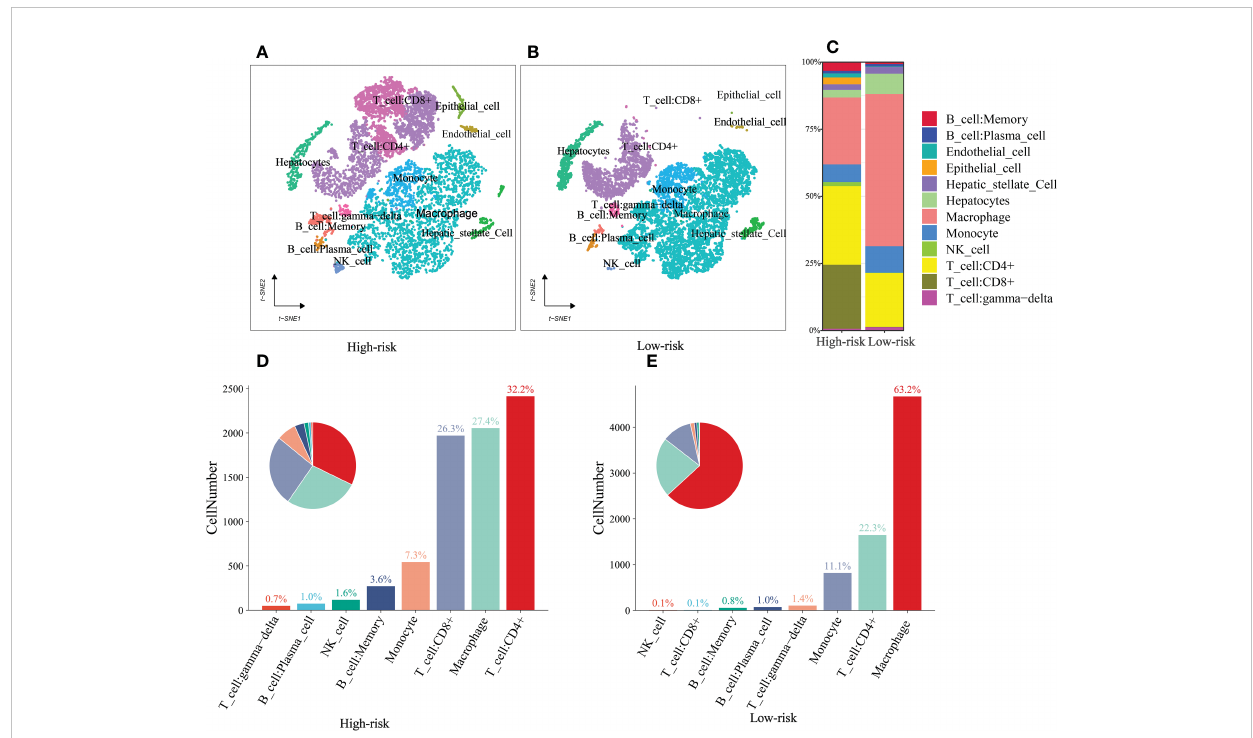
FIGURE 11 single-cell sequencing (A, B) t ‐ SNE plot of 16475 cells showing eight major cell types in high- and low group. (C) The distribution of Memory B cell, Plasma cell, Endothelial cell, Epithelial cell, Hepatic stellate Cell, Hepatocytes, Macrophage, Monocyte, NK cell, CD4+T cell, CD8+T cell, and gd T cells in the low- and high-risk groups. (D, E) The ratio of immune cells in the high- and low-risk